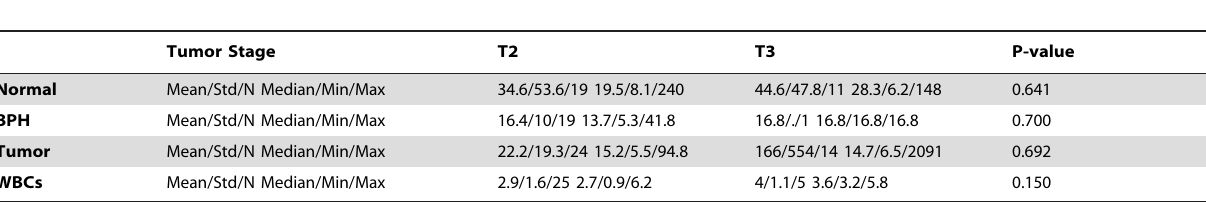
Table 2. Comparison of mtDNA content in normal, BPH, tumor, and WBCs between different stages.